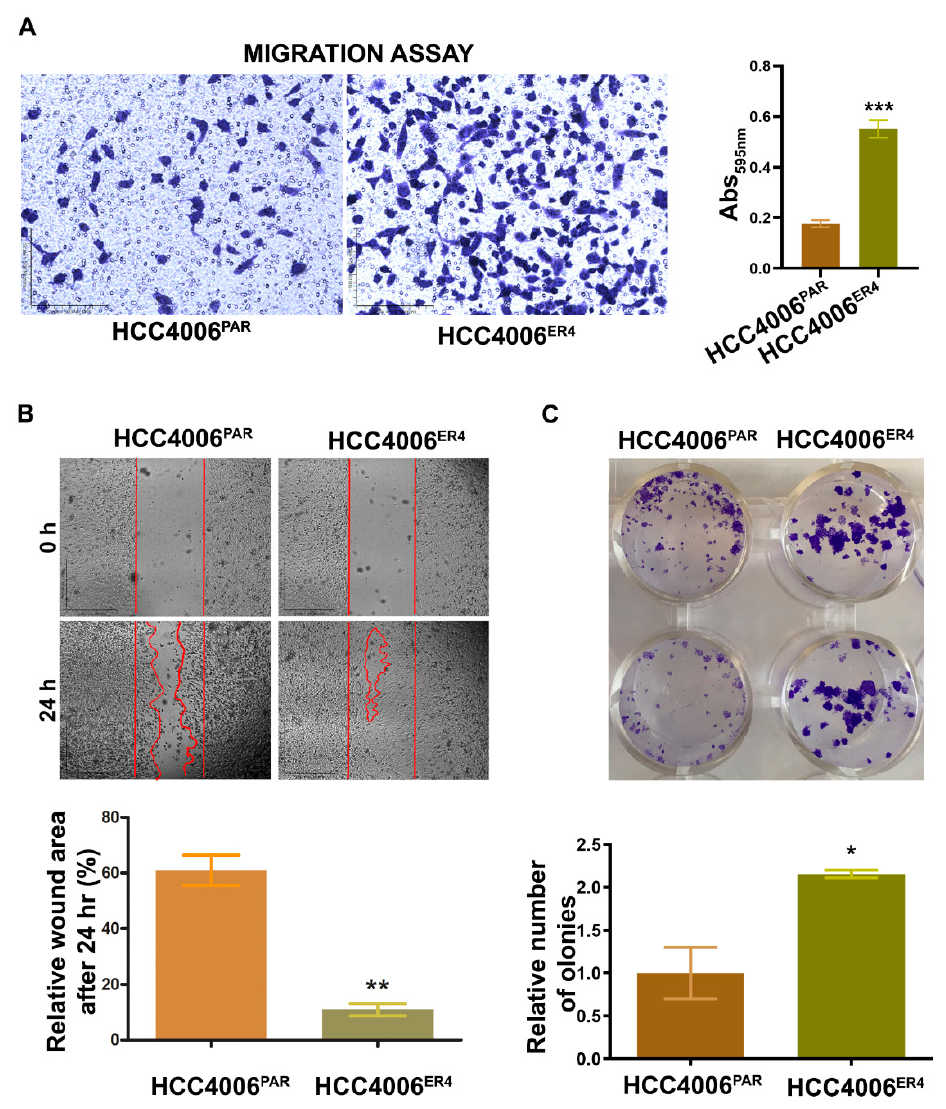
Figure 2. Erlotinib resistance-induced migratory and colony-forming potential of parental and resistant cells. ( A ) The migratory potential of HCC4006 PAR and HCC4006 ER4 cells was determined by the transwell migration assay. The photomicrographs represent the di ff erence in the in vitro migration of HCC4006 PAR and HCC4006 ER4 cells toward the serum for 24 h (Magnification, 10 × ) histogram showing crystal violet absorbance at 595 nm. Values in the bar graphs represent the mean ± SD ( n = 6). *** p < 0.0001 compared to HCC4006 PAR cells. ( B ) Representative phase-contrast images of scratch-wound healing exhibit the motility of HCC4006 PAR and HCC4006 ER4 cells. Cell motility into the wound area was examined and measured by microscopy, and the photomicrograph was taken at 0h and 24h (Magnification, 2 × ). Lower panel shows a bar graph illustrating percentage wound area at indicated time points during the scratch wound assay (** p < 0.005 vs. HCC4006 PAR ). ( C ) HCC4006 PAR , and HCC4006 ER4 cells were allowed to grow for 10 days and colony formation was visualized by staining with crystal violet. The image represents the best of the replicates ( n = 3). Colonies were counted by the Colony Doc-It imaging station using Colony Doc-It imaging software. The bar graph shows the relative number of colonies. Data are expressed as the mean ± SD, * p <